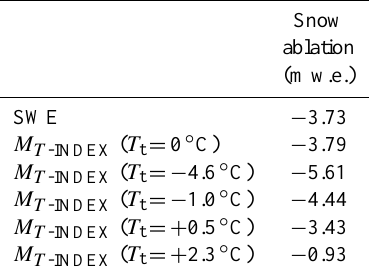
Table 5. The total amount of snow ablation during the actual snow Table 6. Mean degree-day factors for snow melting from the litera- ablation season over the 2006–2010 period measured by sonic ture and from our ranger (SWE) and calculated by the T -index considering different daily air temperature thresholds ( T t ). Snow